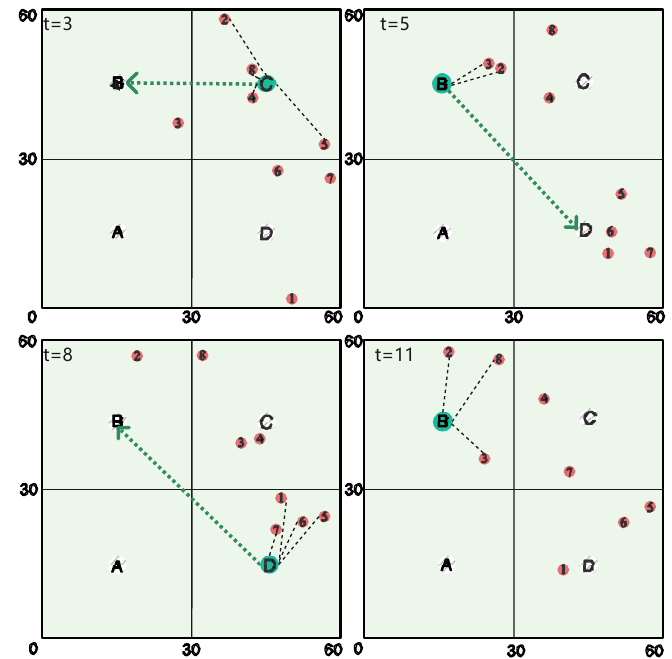
Figure 10. Service path of the UAV with four